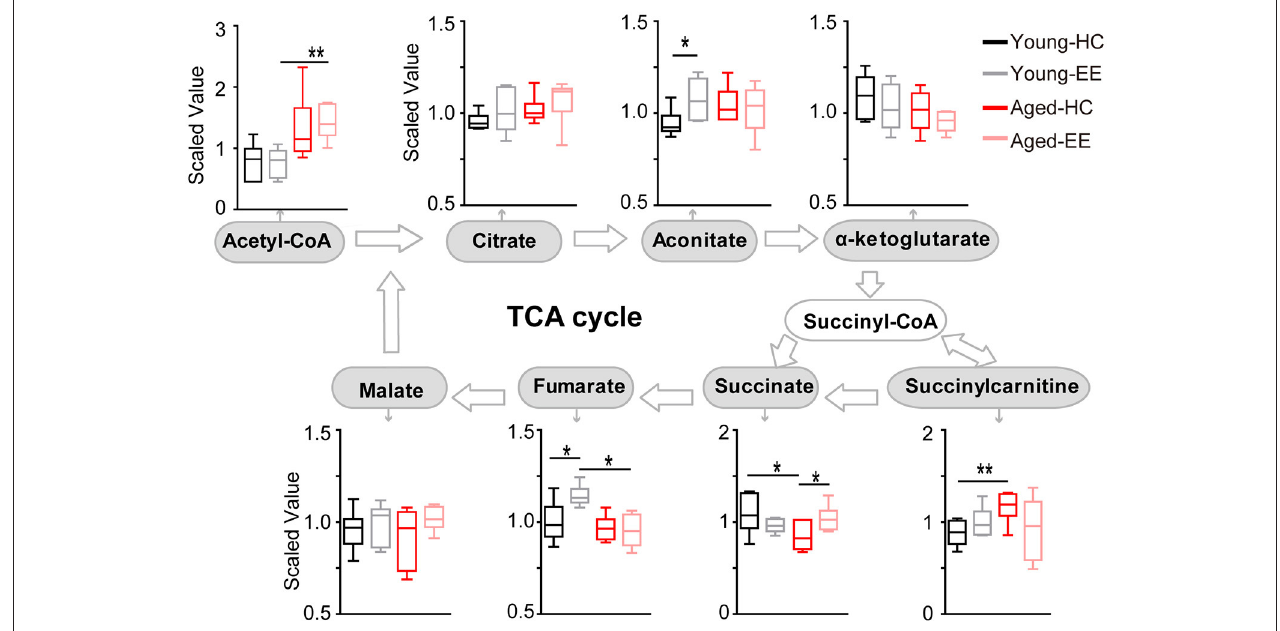
FIGURE 3 | Concentration of metabolites related to the TCA cycle of the aged hippocampus. Box plots of metabolites involved in the TCA cycle show the concentration change between young adult and aged hippocampus under HC and EE condition. TCA cycle key metabolites, including acetyl-CoA, citrate, aconitate, alpha-ketoglutarate, succinate, fumarate, and malate were plot according to the metabolic pathway. * p < 0.05, ** p < 0.01; unpaired t